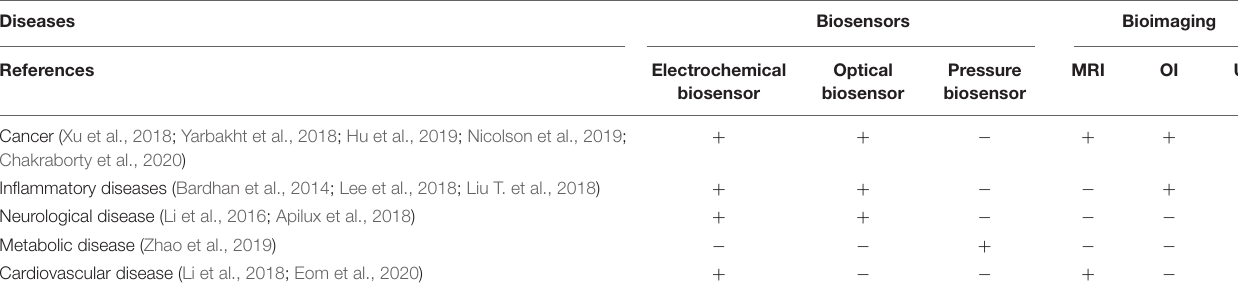
TABLE 3 | Applications of biosensors and bioimaging in the diagnosis of different